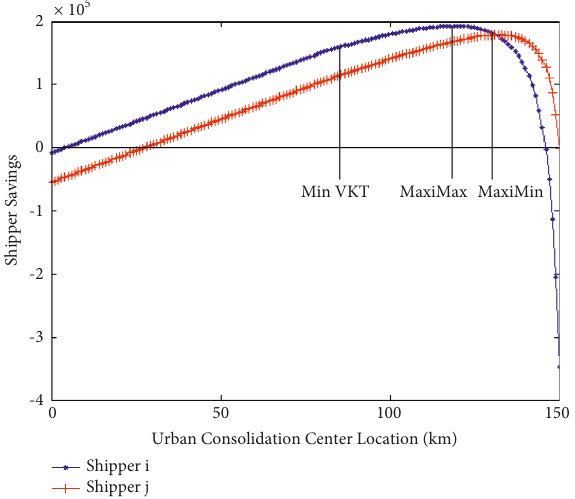
Figure 6: Shipper’s savings and the three objective functions.